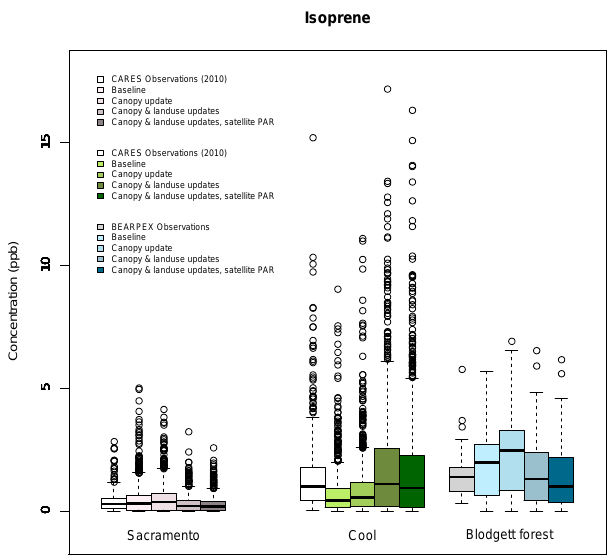
Figure 6. Distribution of observed and modeled isoprene. Observa- tions at Sacramento and Cool represent June 2010. Observations at Blodgett Forest match the modeled